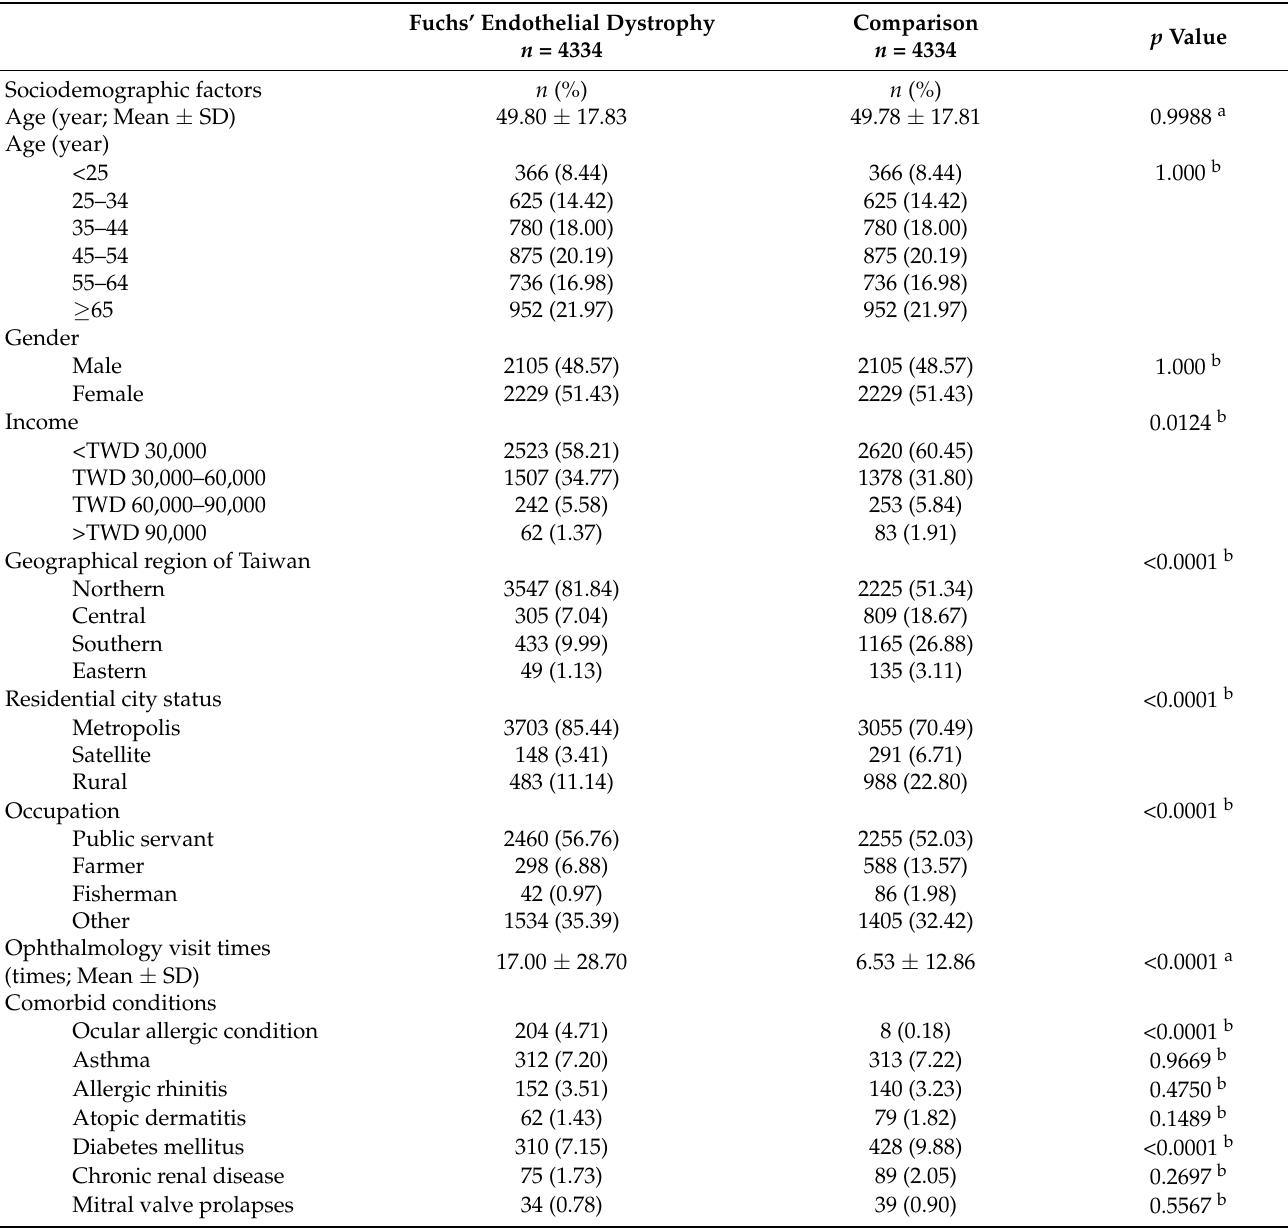
Table 1. Baseline sociodemographic factors and comorbid conditions of Fuchs’ endothelial dystrophy patients and control subjects after propensity score matching by age and gender. Fuchs’ Endothelial Dystrophy n = 4334